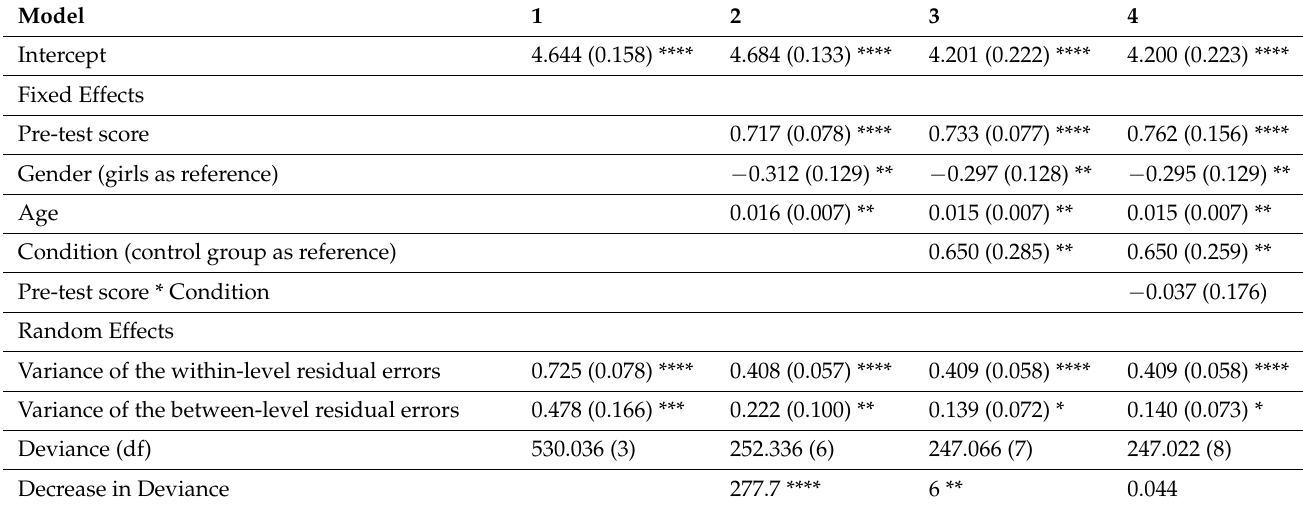
Table 5. Multilevel models explaining the prosocial post-test score ( N =